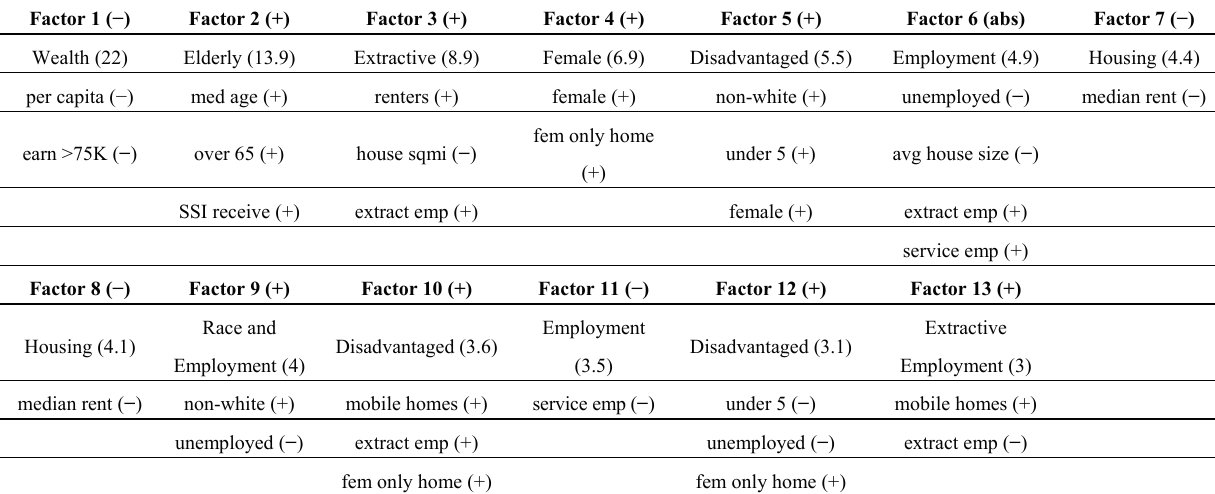
Table 2. Traditional Social Vulnerability Index (SoVI) factors with cardinality, factor name and proportion of variance explained (rounded), and dominant social variables with factor loading